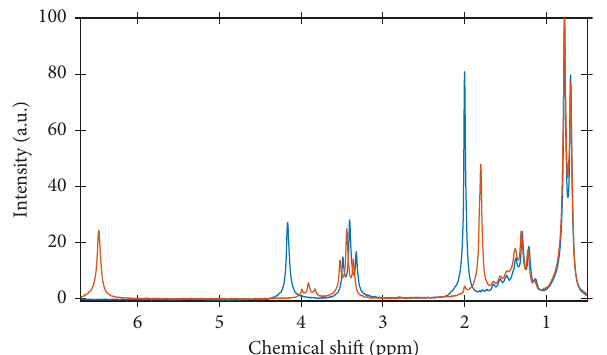
Figure 2: 1D 1 H NMR spectra of the biocatalyzed hydrolysis in the microreaction system. Spectrum at 0 min (blue) and at the end of process monitoring after 1380min